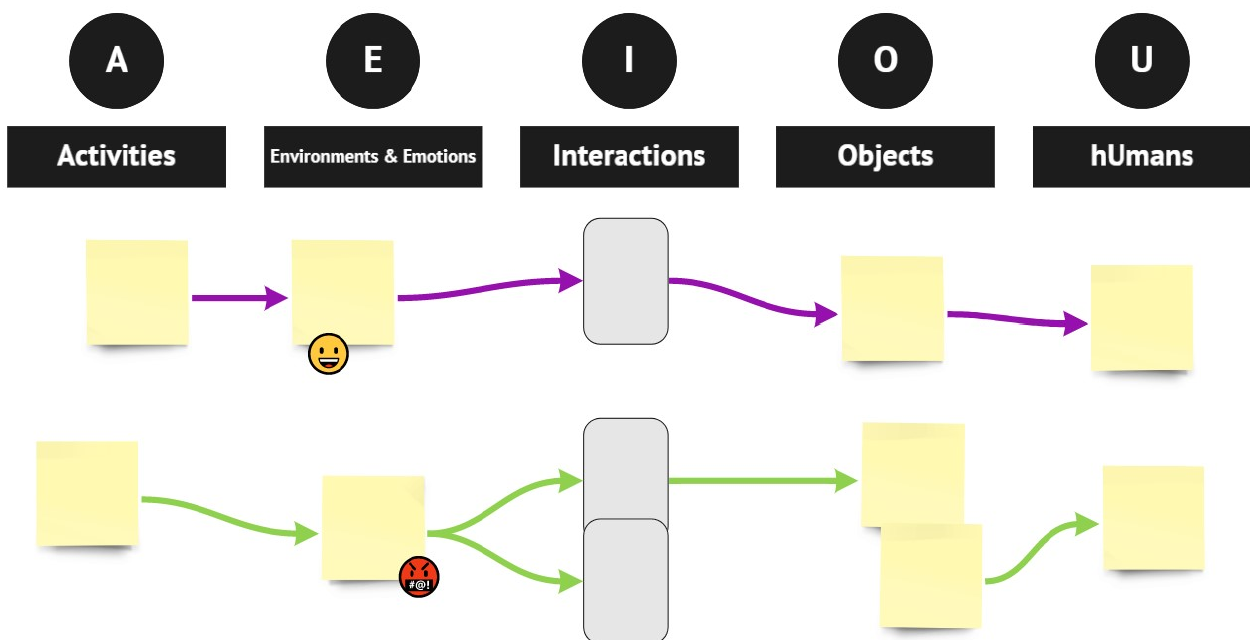
Figure 3. Two user flows for the definition of a